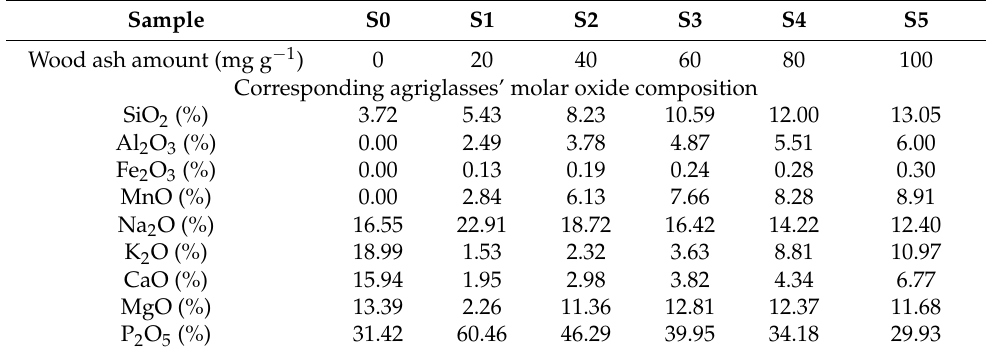
Table 2. Wood ash content and corresponding oxide composition of the studied glass fertilizers.